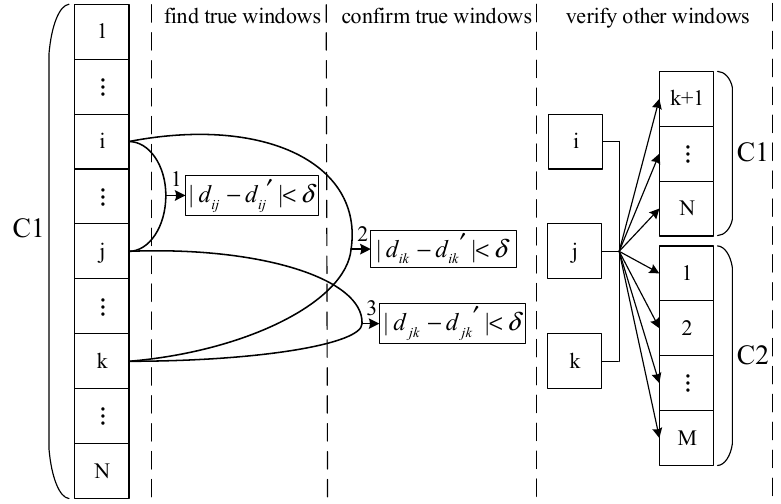
Figure 6. The flow diagram of eliminating fake stars.